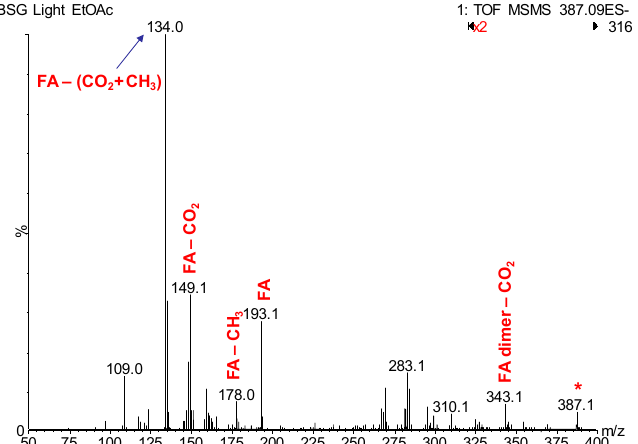
Figure 3. Electrospray ionisation (ESI)-MS / MS of m / z 387.1 showing the fingerprint fragment ions of the ferulic acid dimer. (FA = ferulic acid).